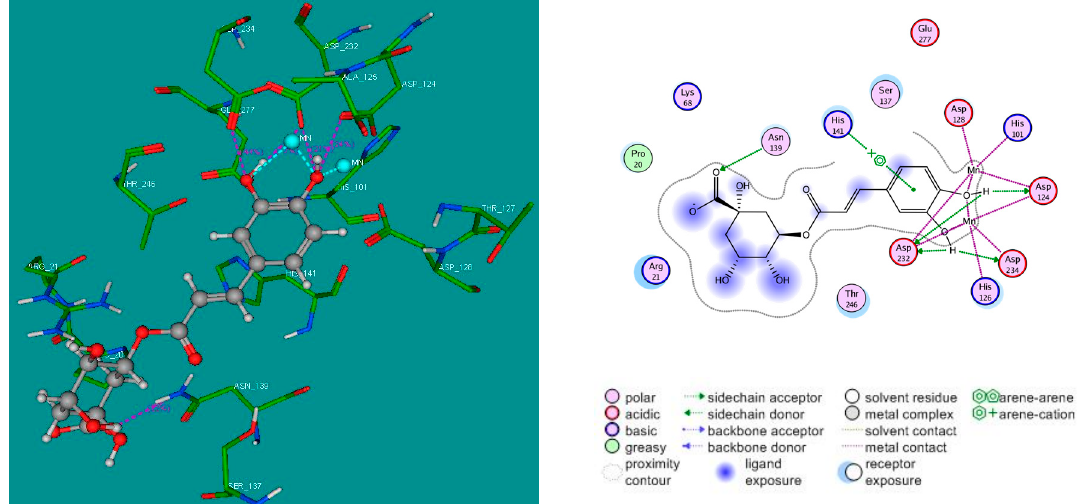
Figure 4. 3D ( left ); and 2D ( right ) binding modes of CGA inside the active site of h-ARG I. For the 3D binding mode, CGA is represented as a “ball and stick” form: C ( grey ), O ( red ), and H ( white ); manganese ions are represented as cyan spheres; and the crucial residues of the binding site are represented by lines. H-bonds are represented as pink dotted lines, while the metal coordination bonds are represented by cyan dotted lines. Docking simulations were performed by FlexX program implemented in LeadIt 2.0.2 software, and the pictures of docking solution were created by MOE 2008.10 software.